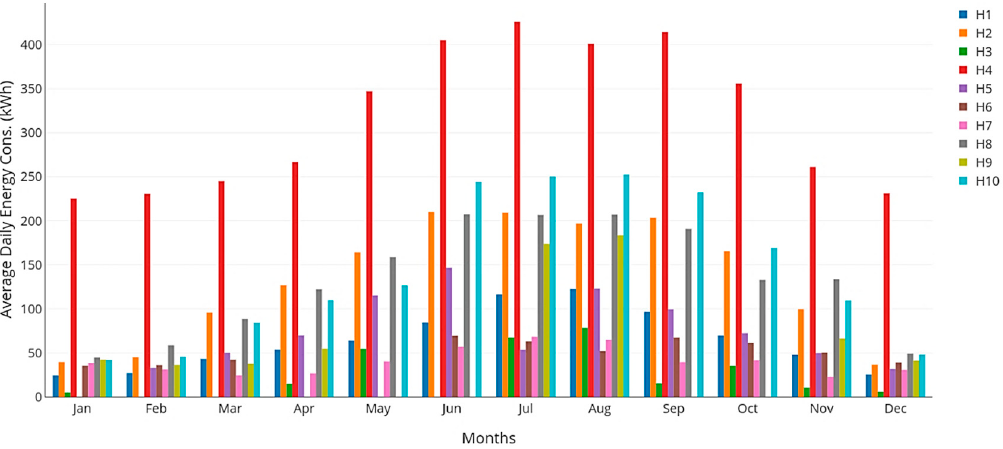
Figure 7. Average daily energy consumption per month for houses H1–H10.